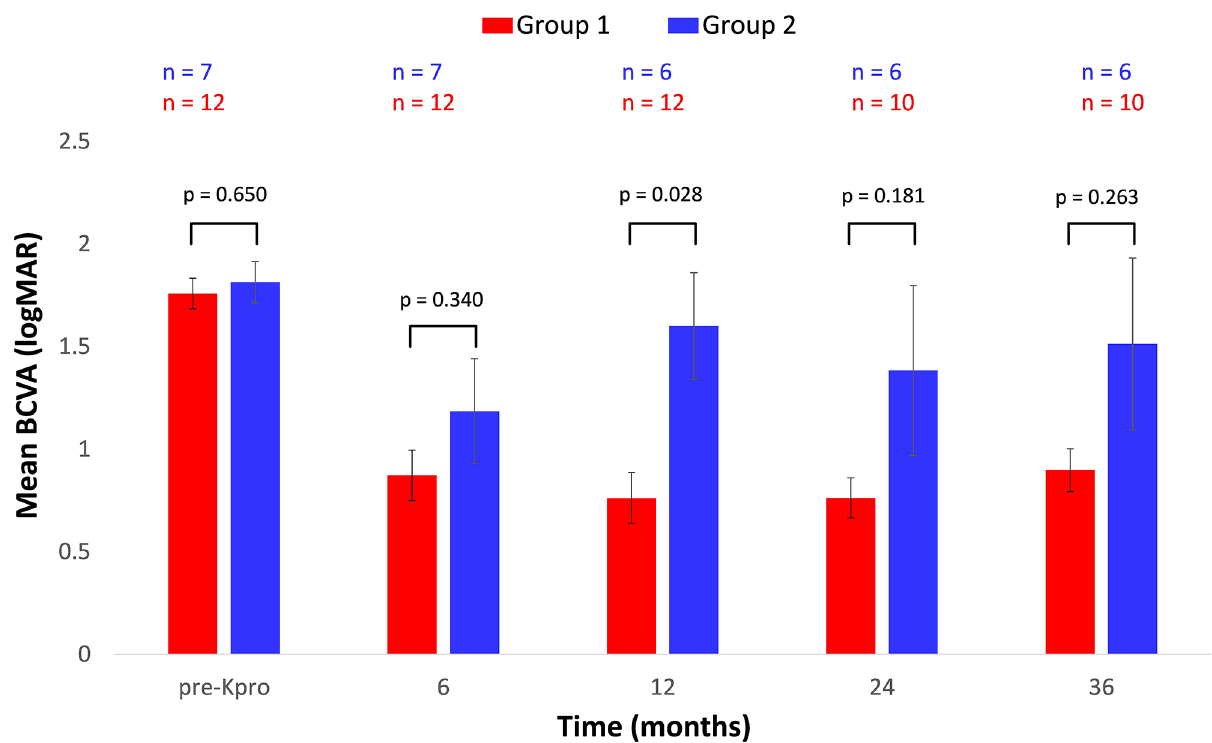
Fig 1. Mean best corrected visual acuity (BCVA) before Keratoprosthesis (pre-Kpro) and at severaltime points post-KPro implantation for patients with or without prior or concurrent glaucoma surgical intervention. Group 1 = patients who had glaucoma surgery prior to or concurrentlywith Kpro; Group 2 = patients with no history of glaucomasurgery or surgery (cid:21) 3 months post-Kpro. P-values calculatedwith Mann-Whitney U nonparametric t-test. n denotesnumber of eyes. Error bars represent StandardError of the Mean. Statistical significanceis definedas p <